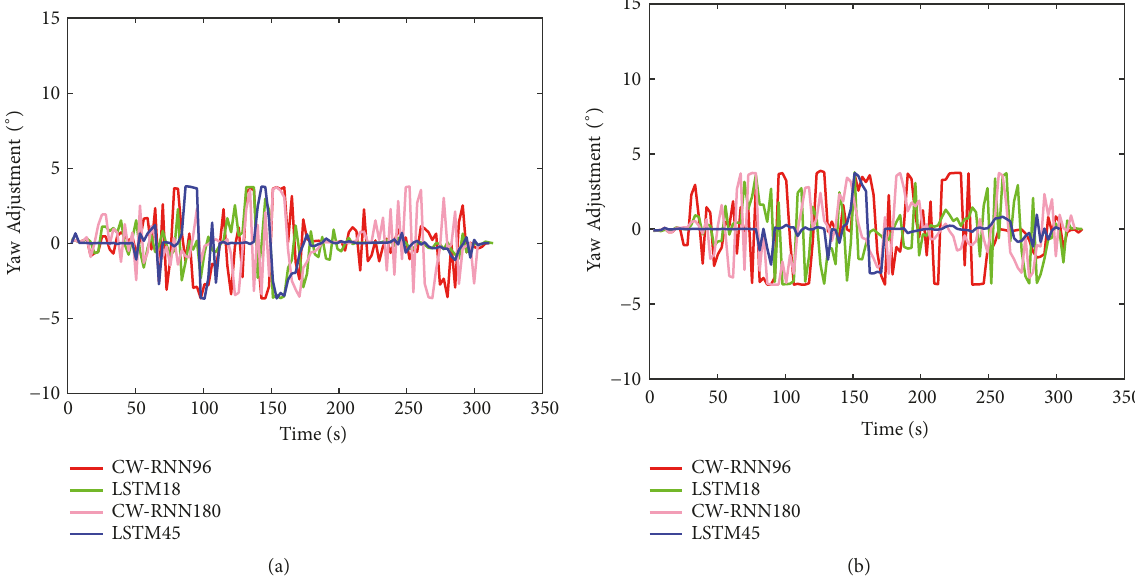
Figure 7: Curves of yaw adjustment output by the four obstacle avoidance algorithms in simulation test cases 1(a) and (b).